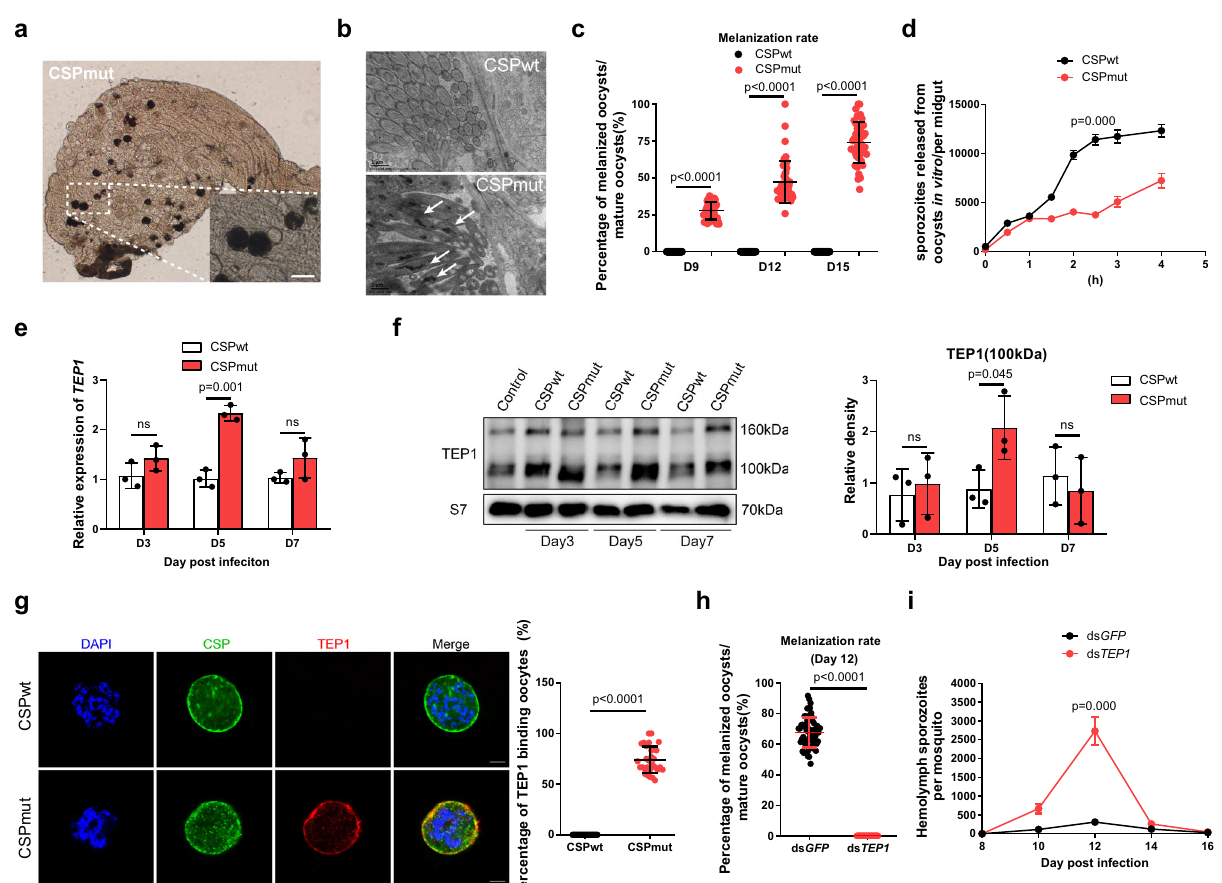
Fig. 2 Parasite development arrest largely depends on TEP1-mediated mature CSP mut oocyst melanization. a Representative image of melanized Plasmodium yoelii CSP mut in mosquitoes under a light microscope on day 12 after a blood meal; scale bar 50 μ m. b Representative electron micrograph of vacuolized or melanized sporozoites (white arrows) from P. yoelii CSP wt and CSP mut oocysts at day 11; scale bar 1 μ m. c Statistical analysis between the percentage of melanized mature P. yoelii CSP wt and CSP mut oocysts in mosquitoes ( n = 45) at the indicated time points post blood feeding. d Average number of sporozoites released from P. yoelii CSP wt and CSP mut oocysts in mosquitoes ( n = 60) at indicated incubation times in vitro. e mRNA expression level of TEP1 in mosquitoes ( n = 15) infected with P. yoelii CSP wt and CSP mut at the indicated time points post blood feeding determined using real-time PCR. f TEP1 activation (100 kD band) in hemocytes from mosquitoes ( n = 40) infected with P. yoelii CSP wt and CSP mut parasites detected using western blot; S7 protein was used as an internal control (left). Pooled data was quanti fi ed and analyzed (right). g Representative image of TEP1 binding to P. yoelii CSP wt and CSP mut oocysts at day 7 PI stained with anti-CSP repeat and anti-TEP1 (left), and the percentage of oocysts from P. yoelii CSP wt or CSP mut parasite-infected mosquitoes ( n = 30) bound with TEP1 was statistically analyzed (right); scale bar 10 μ m. Percentage of melanized mature oocysts ( h ) in P. yoelii CSP mut parasite-infected mosquitoes ( n = 60) at day 12 PI, and average number of hemolymph sporozoites ( i ) in mosquitoes ( n = 60) infected with CSP mut parasites at the indicated time points compared following TEP1 knockdown. d – f A two-sided Student ’ s t -test was used for the statistical analysis. c , g – i A two-sided Mann – Whitney U test was used for the statistical analysis. The data were presented as the means ± SD; ns, no signi fi cance; p -values were shown. The data were combined based on three independent experiments ( c – i ) or two independent experiments ( b ). Source data are provided as a Source Data fi